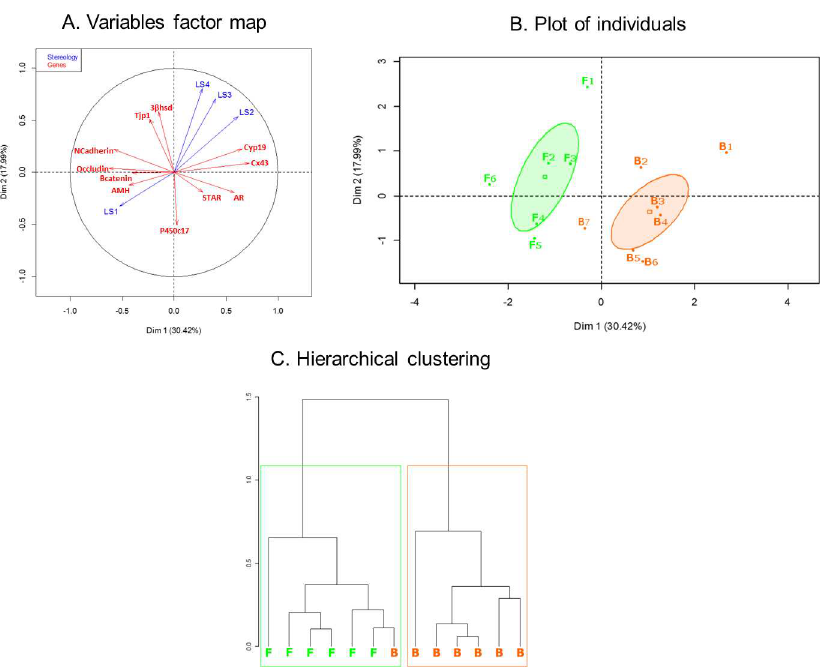
Fig 6. Variables factor map (A), plot of individuals (B) and hierarchical clustering (C) of the Multiple Factor Analysis (MFA) applied on gene expression (red arrows) and stereological (blue arrows) results. On the plot of individuals, foals born to dams that were fed with forage only (n = 6) are representedby the letter F and foals born to dams that were fed with barley and forage (n = 7) are represented by the letter